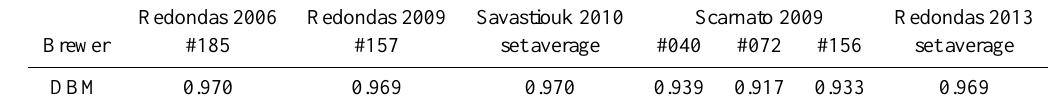
Table 5. Ratio of the differential ozone absorption coefficient to the operative ones compared with results from other studies.